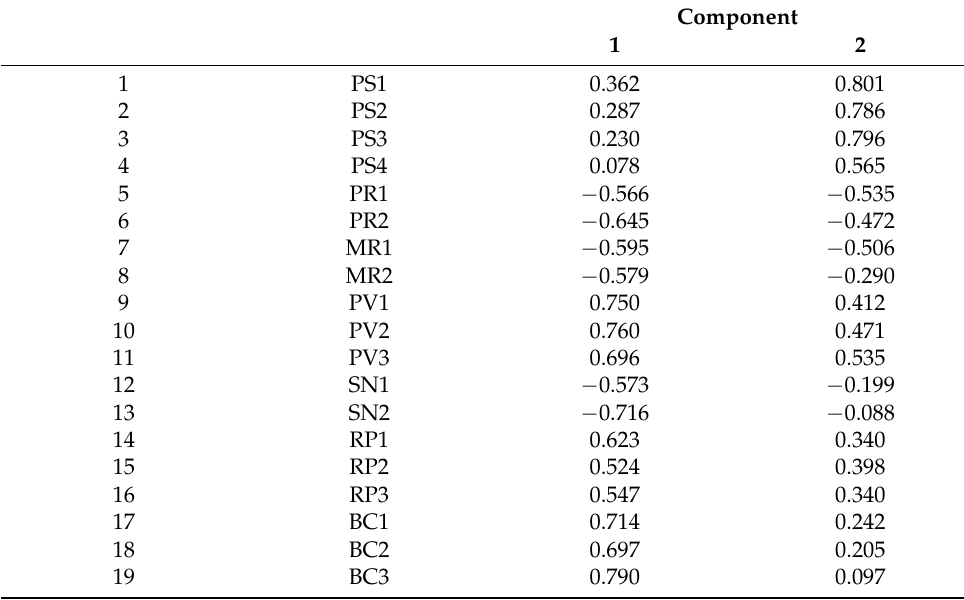
Table 5. Rotated component matrix.